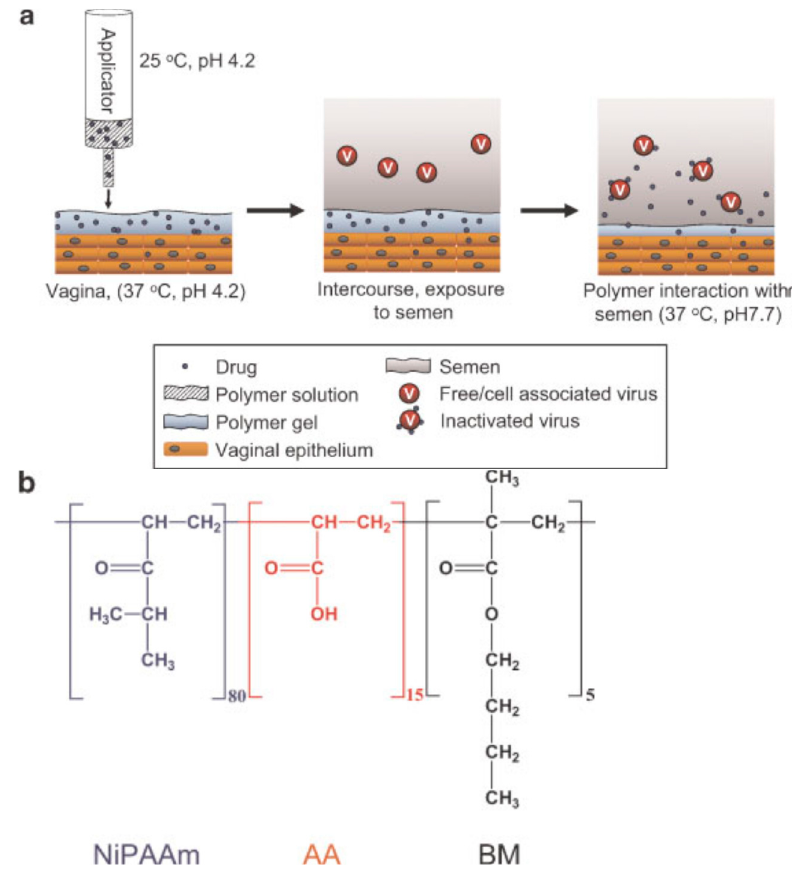
Figure 10. ( a ) Schematic of the expected behaviour of the polymer in response to the temperature and pH stimuli. The viscosity of the polymer solution is expected to increase due to gelation with the increase in temperature during application, thus leading to decrease in diffusion coefficient of the entrapped drugs. Upon exposure to semen, the gel loses its mechanical properties and transitions to a liquid again, which in turn will increase the diffusion coefficient of the drug drastically and promote rapid drug release along with the polymer and subsequent inactivation of virus in the semen. ( b ) Linear terpolymer of N-isopropyl acrylamide (NiPAAm), acrylic acid (AA), and butyl methacrylate (BM) synthesized with a feed ratio of 80:15:5, respectively. NiPAAm is the thermosensitive component while AA is the pH sensitive component. Adapted from “Temperature and pH sensitive hydrogels: an approach towards smart semen-triggered vaginal microbicidal vehicles” by Gupta et al. [150].